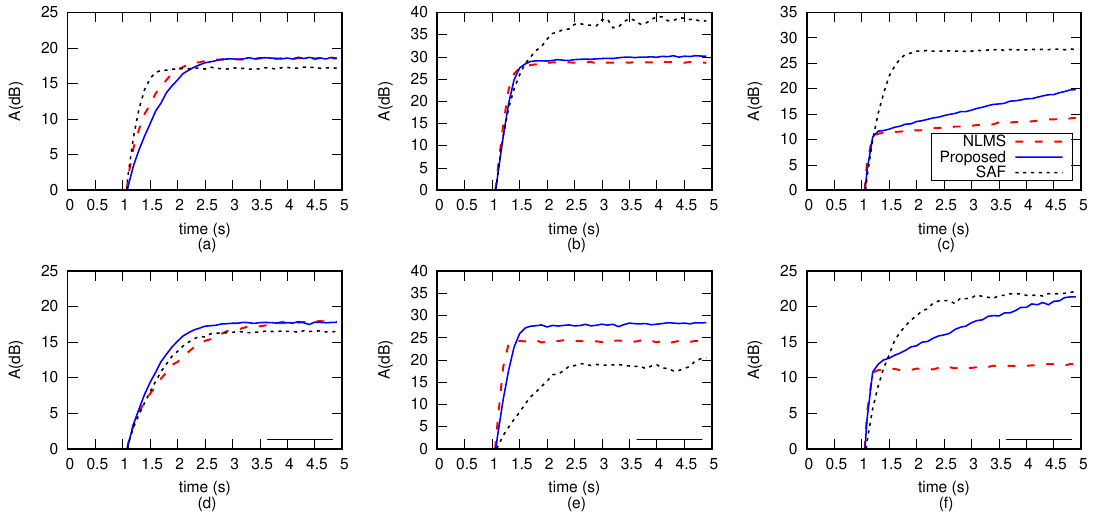
Figure 6. Test case 1: comparison of the noise reduction achieved in an ANC system, where: ( a ) x ( n ) is white noise and plant noise ratio is 60 dB; ( b ) x ( n ) is multi-tonal noise and plant noise ratio is 60 dB; ( c ) x ( n ) is mono-tonal noise and plant noise ratio is 60 dB; ( d ) x ( n ) is white noise and plant noise ratio is 10 dB; ( e ) x ( n ) is multi-tonal noise and plant noise ratio is 10 dB; ( f ) x ( n ) is mono-tonal noise and plant noise ratio is 10 dB; The control filter length is L = 256. Legend is the same for all